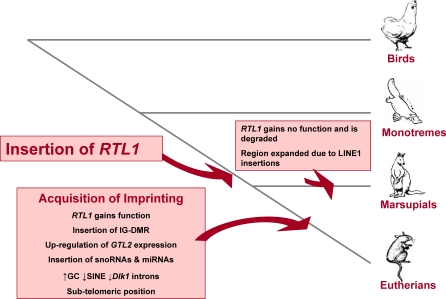
Evolution of the Dlk1-Dio3 Domain in Mammals.Schematic illustration of the evolution of the Dlk1-Dio3 domain in mammals. RTL1 retrotransposed into the region before the divergence of the eutherians and metatherians. In the marsupial lineage, RTL1 did not gain a function (or lose it) and became degraded. The region expanded approximately 2-fold in the marsupials; this expansion is mainly due to the accumulation of LINE1 repeats. The snoRNA and miRNA clusters arose after eutherian diverged from marsupials but before the mammalian radiation which took place around 98 million years ago. The eutherian region has also evolved many genomic features associated with imprinted clusters. The entire domain has become increasingly GC-rich, whereas a decline in GC content is the general trend in eutherian genomes. There are fewer SINEs than expected in the region, and the introns of the DLK1 transcript have become shorter. Finally the region has a sub-telomeric position within the eutherian genome whereas in monotremes and marsupials it is in the middle of the chromosome arm. Not drawn to scale